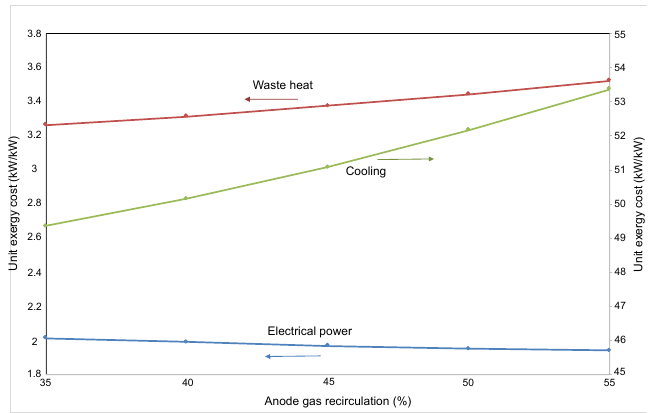
Figure 9. Variation of the unit exergy cost of electricity and exhaust gases as a function of the anode gas